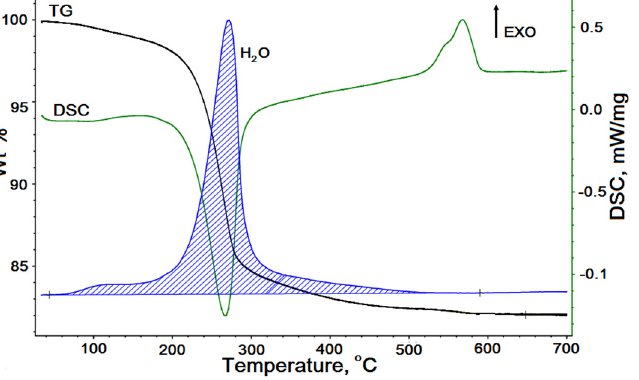
Figure 4. Synchronous thermal analysis curves obtained during the thermal decomposition of a ZnSn(OH) 6 sample: mass change (TG), thermal effects (DSC), and the ionic current of the mass spectrometer measured for the atomic mass number m / z of 18 amu corresponding to water molecules evolving from the sample.